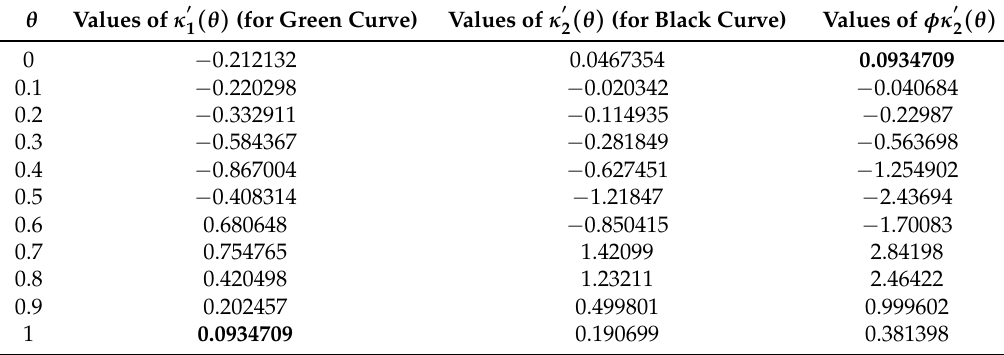
Figure 13. Graphical representation of the G 3 continuity for the GHT-Bézier curve and classical Bézier curve. ( a ) G 3 continuity between two quartic GHT-Bézier curve segments; ( b ) comparison of the derivative of curvature between the classical Bézier curve and GHT-Bézier curve. Table 3. Curvature values for G 3 continuity by the classical Bézier